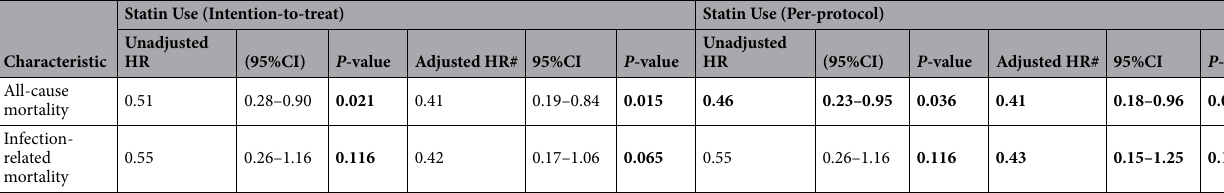
Table 6. Association of statin use with mortality in patients with cardiovascular disorders. # Adjusted for